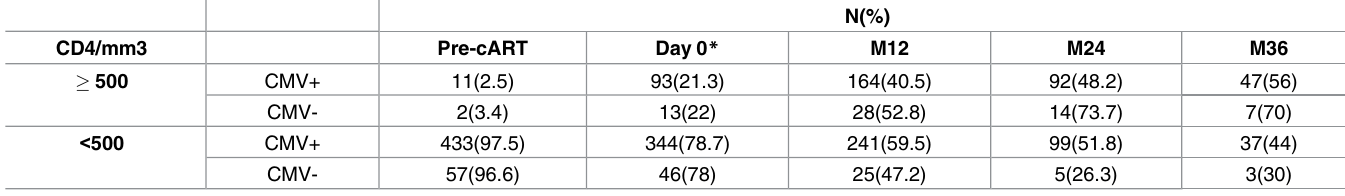
Table 3. Recoveryof the CD4+ T cell compartment in CMV seropositive and CMV seronegative HIV-infected patients on first-line